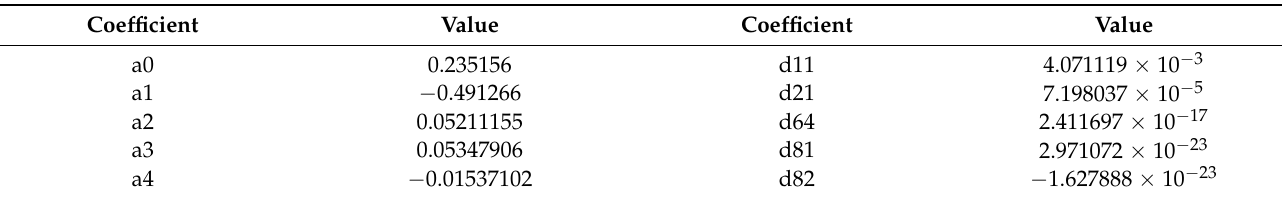
Table A3. Viscosity calculation